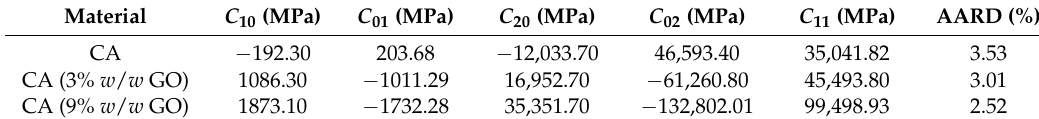
Table 6. Parameters and deviations for the polynomial model.